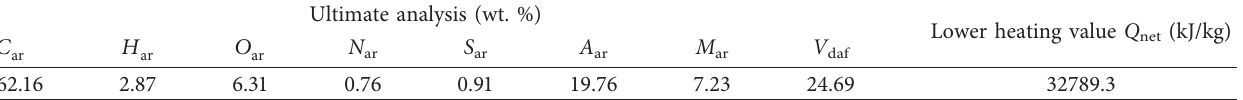
Table 3: Ultimate analysis of